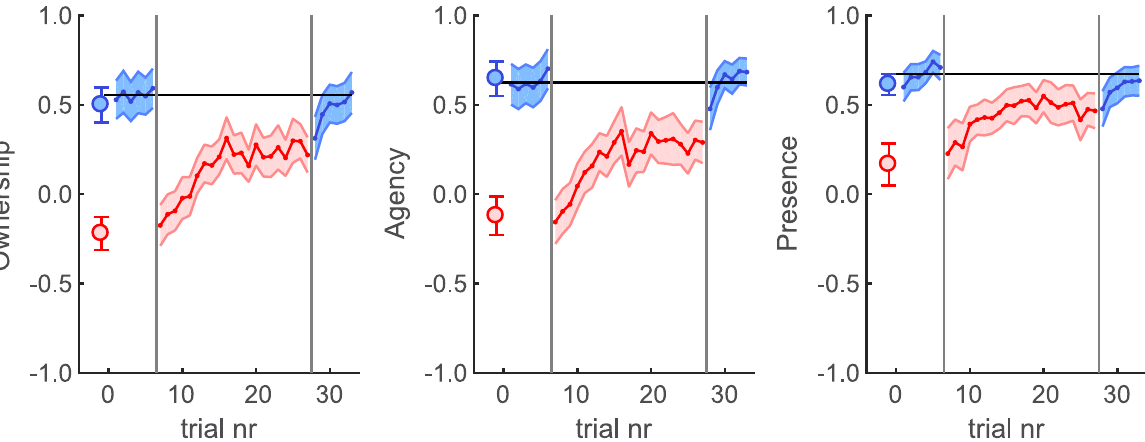
Fig 5. Scaling task results during the delay exposure experiment. From left to right the scaling task results are shown for ownership, agency and presence, respectively. Colour schemes are the same as for Fig 4.